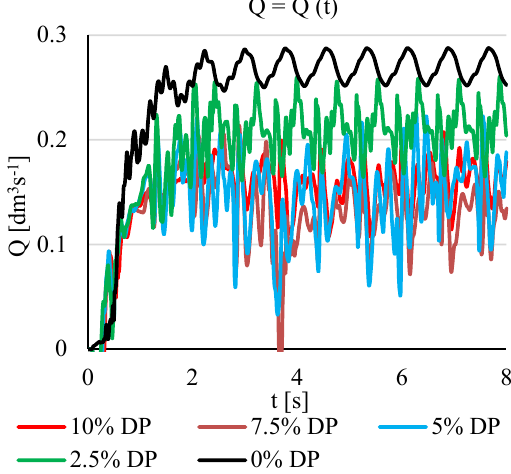
Fig. 2 Flow in the rigid tube with different fraction of the dispersed phase The flow in Fig. 2 fluctuates more than would be expected, and also changes more sharply than expected for individual dispersed phase (DP) fractions. This could be partly due to the simulated quarter of the